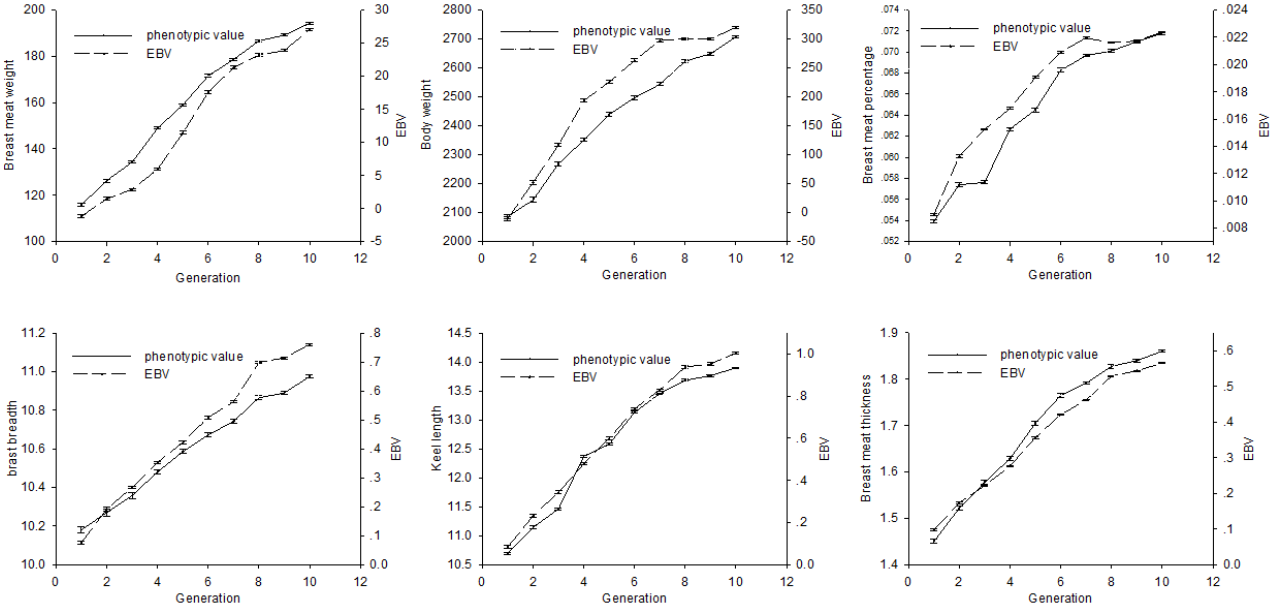
Figure 2. Generational average phenotypic values and estimated breeding values (EBVs), reflecting genetic trends for breast meat related traits. Vertical lines denote standard